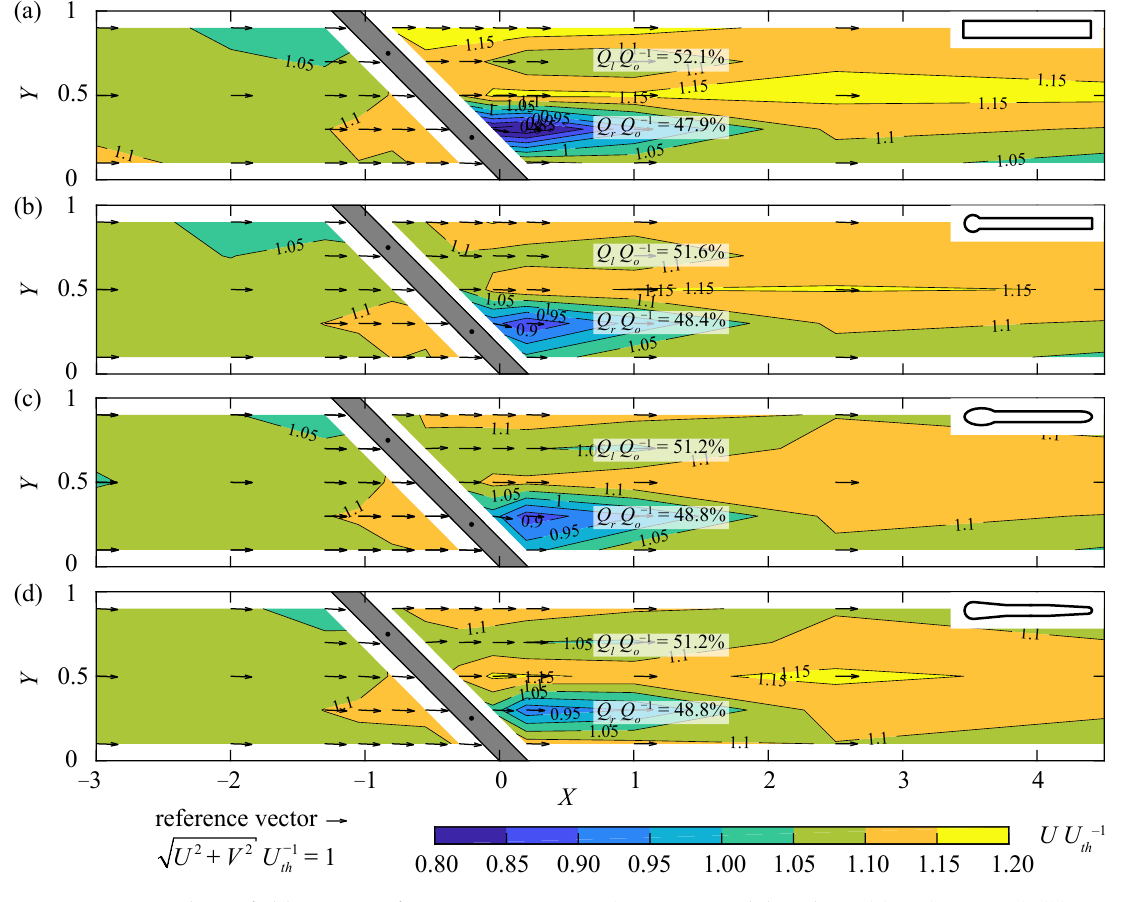
Figure 5. Velocity field at Z = 0.5 for s b = 20 mm, α = 45 ◦ , H Ov = 0 with bar shape ( a ) S1 ( ξ R = 0.50), ( b ) S2 ( ξ R = 0.33), ( c ) S3 ( ξ R = 0.23), and ( d ) S4 ( ξ R =